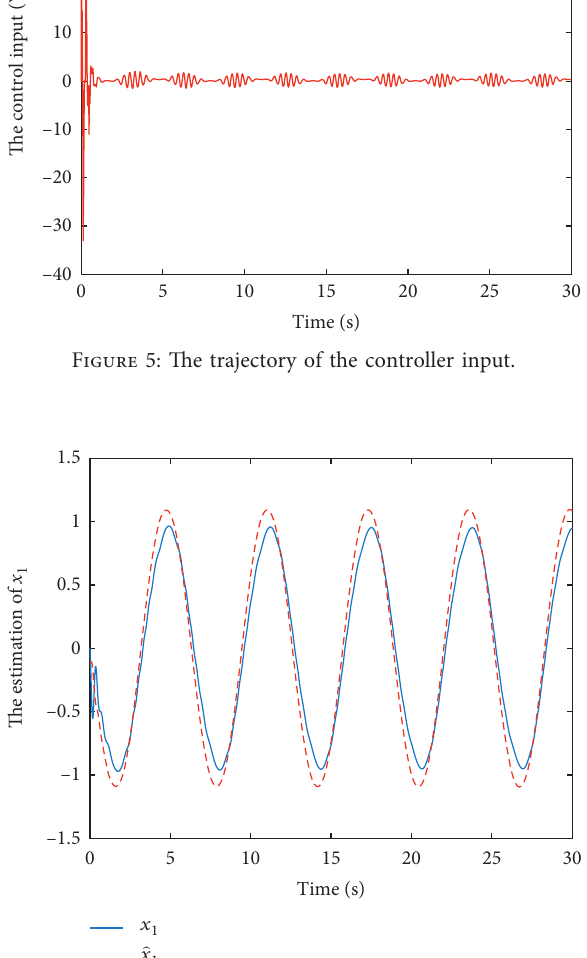
Figure 6: The estimation of x